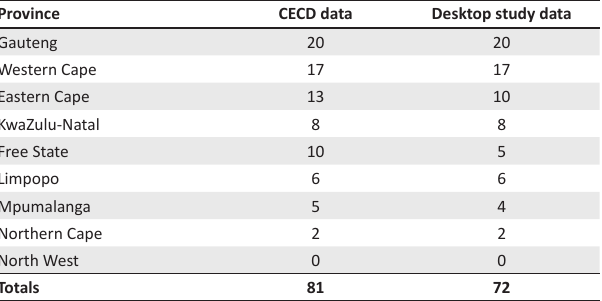
TABLE 2: Technical and vocational education and trainings campuses offering early childhood care and education by